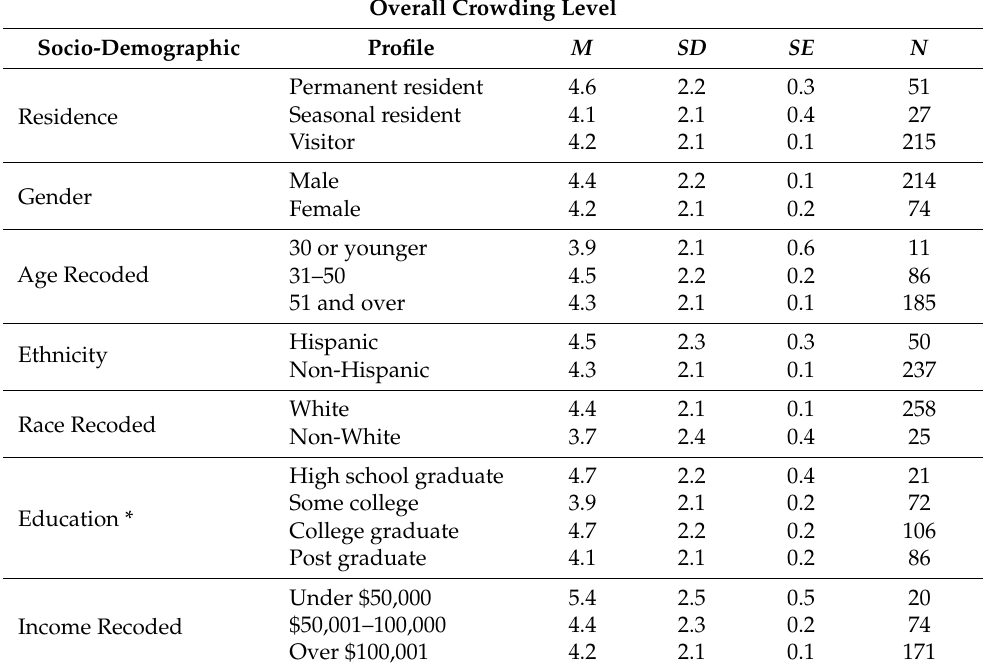
Table 5. Means of overall crowding level by socio-demographic categories in survey